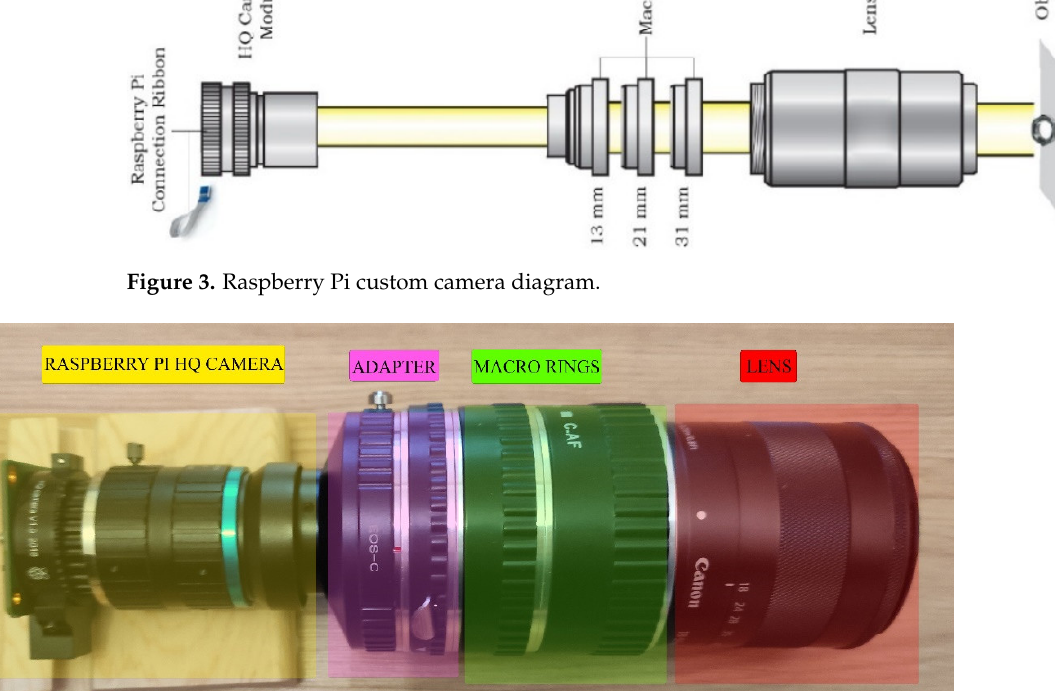
Figure 4. Real version of the camera that we built for our research.